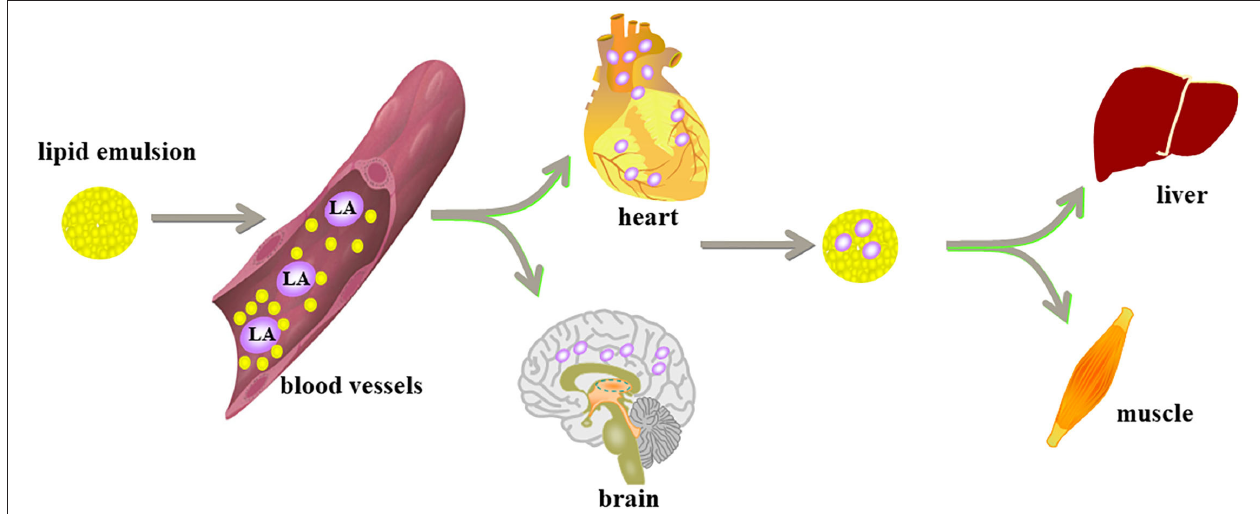
FIGURE 1 | Lipid emulsion enters the blood system to form “lipid sink” and wrap local anesthetics and remove them from various tissues and organs. Lipid emulsion is like a shuttle subway. It combines local anesthetics in the heart and the brain, which are most sensitive to the decline of blood oxygen, and is distributed to the liver and muscle tissue to begin detoxification and